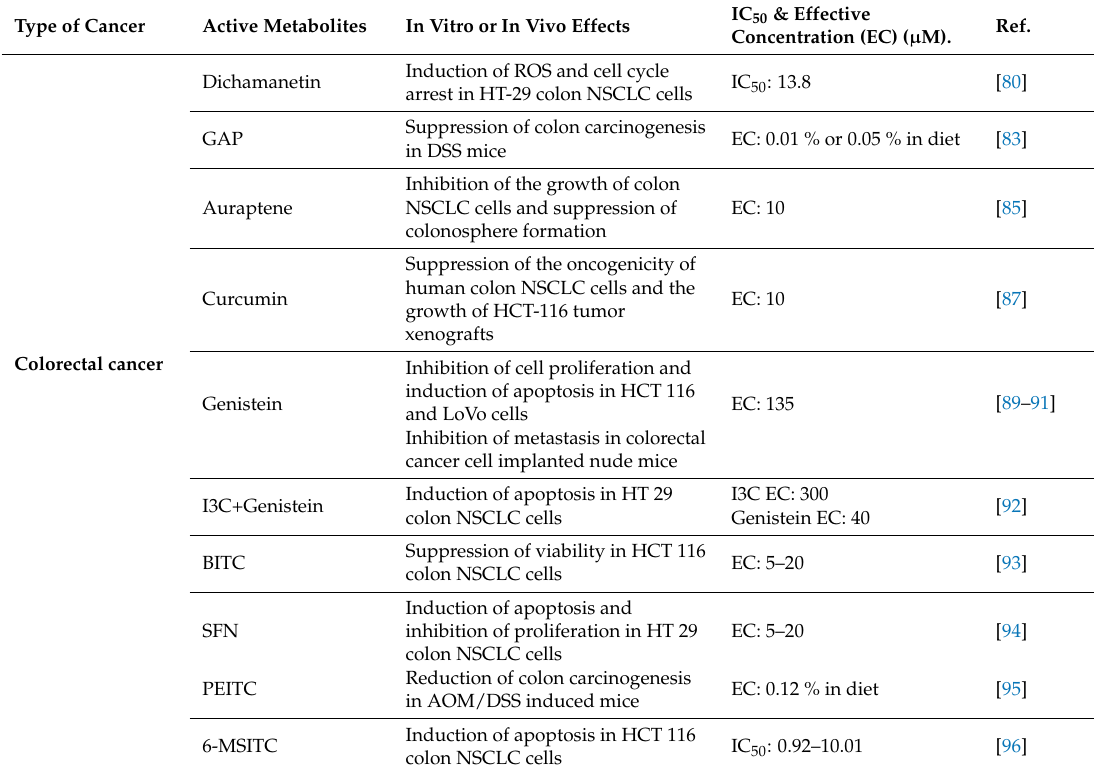
Table 2. Anti-cancer effects of active metabolites from plants in different types of